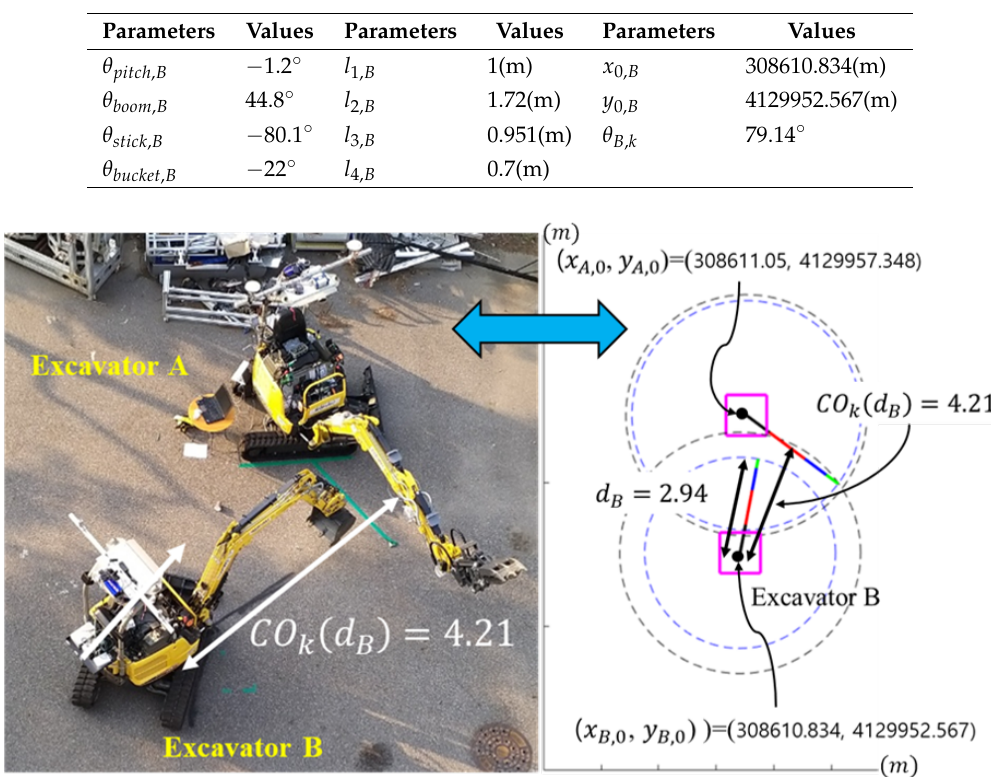
Figure 20. The experimental set-up: Excavator B is closer to Excavator A (in contrast with Figure